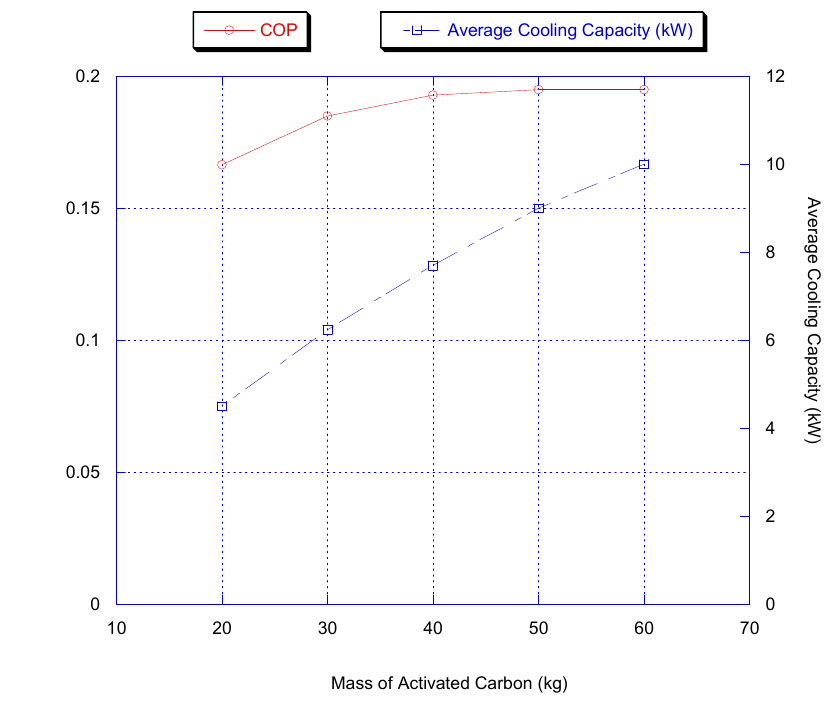
Figure 2. Effect of activated carbon mass on chiller average cooling capacity and COP (results are at chiller nominal operating conditions, shown in Appendix B).